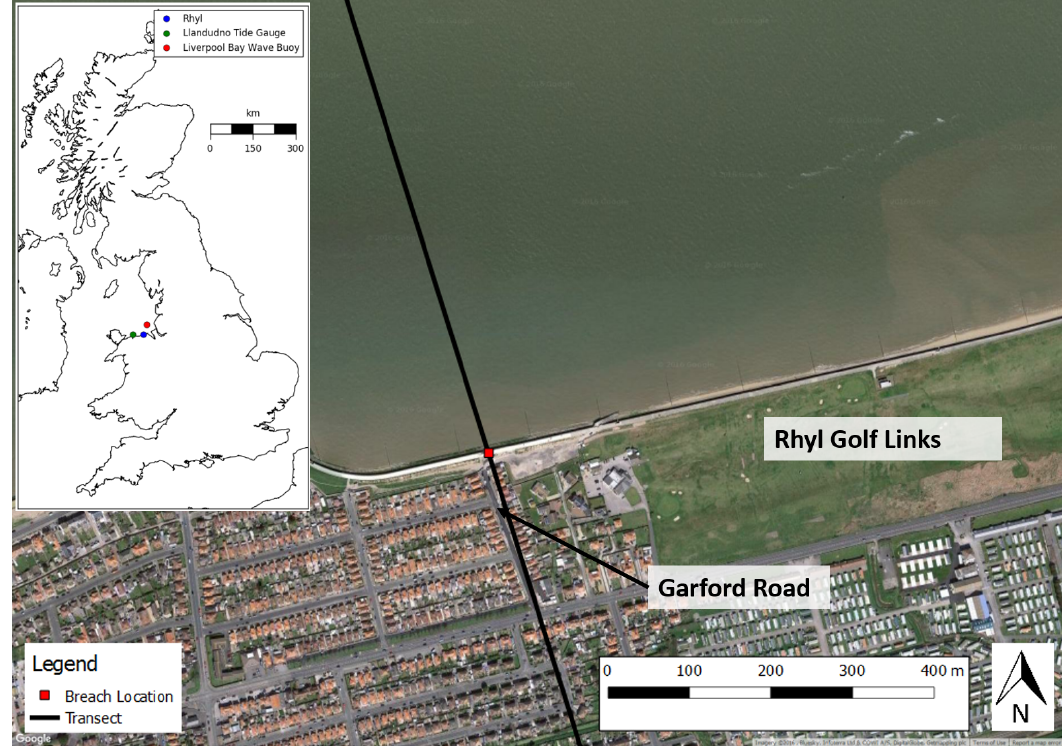
Figure 1. Satellite imagery of the study area, the breach at Garford Road and Rhyl Golf Links [43] and the location of Rhyl, Llandudno Tide Gauge and Liverpool Bay Wave Buoy within the